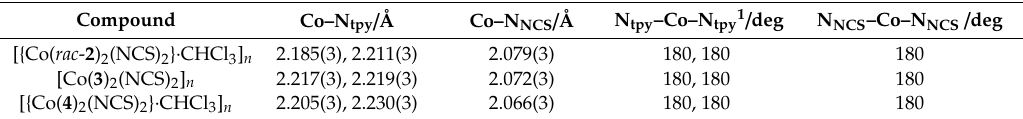
Figure 5. ORTEP representations of the coordination sphere of atom Co1 (with symmetry generated Co centers) in ( a ) [Co( 3 ) 2 (NCS) 2 ] n (symmetry codes: i = 2– x , 2– y , 1– z ; ii = 3 / 2 – x , – 1 / 2 + y , 1 / 2 – z ; iii = 5 / 2 – x , 1 / 2 + y , 3 / 2 – z ; iv = 3 / 2 – x , 1 / 2 + y , 1 / 2 – z ; v = 1 / 2 + x , 3 / 2 – y , 1 / 2 + z ) and (b) [{Co( 4 ) 2 (NCS) 2 } · CHCl 3 ] n (symmetry codes: i = 1– x , 1– y , – z ; ii = 1 / 2 – x , 1 / 2 + y , – 1 / 2 – z ; iii = 3 / 2 – x , – 1 / 2 + y , 1 / 2 – z ; iv = – 1 / 2 + x , 1 / 2 – y , – 1 / 2 + z ; v = 3 / 2 – x , 1 / 2 + y , 1 / 2 – z ). Ellipsoids are plotted at 40% probability level and H atoms are omitted. Table 2. Selected bond lengths and angles 1 in [{Co( rac - 2 ) 2 (NCS) 2 } · CHCl 3 ] n , [Co( 3 ) 2 (NCS) 2 ] n and [{Co( 4 ) 2 (NCS) 2 } · CHCl 3 ] n .